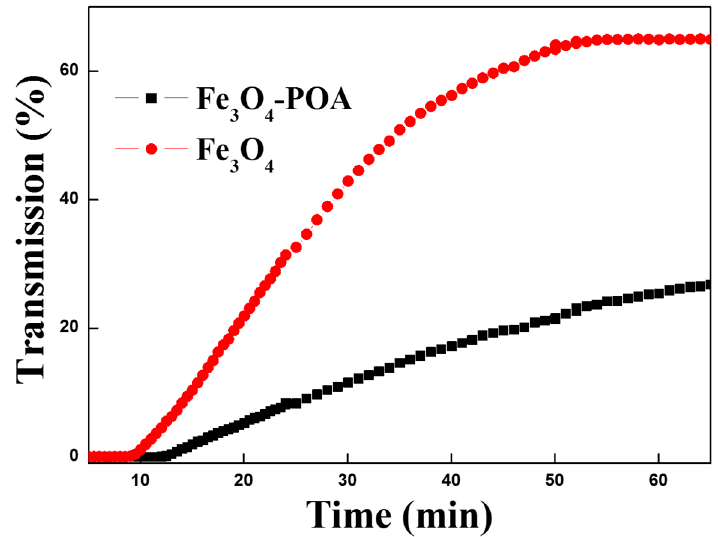
Figure 12. Transmission profiles of pure Fe 3 O 4 and Fe 3 O 4 /POA MR suspension.